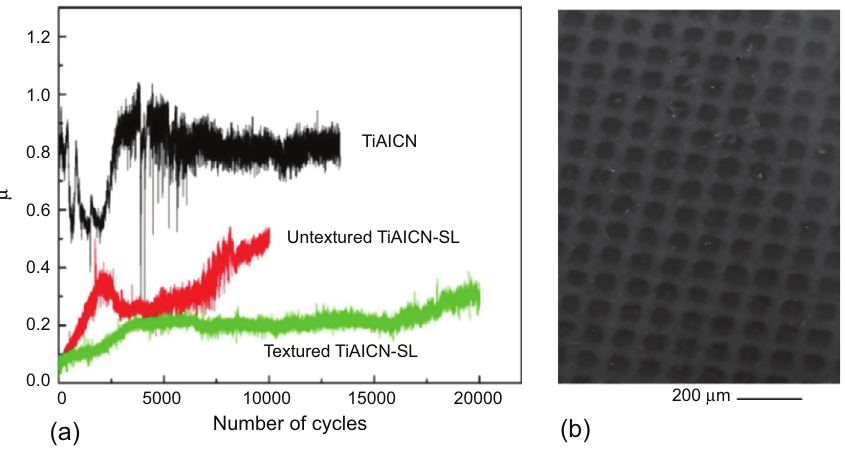
Figure 8. (a) CoF for TiAlCN, textured and untextured TiAlCN+ Mo/MoS 2 /Ag coatings recorded at 570 (cid:2) C against Si 3 N 4 ball with a load of